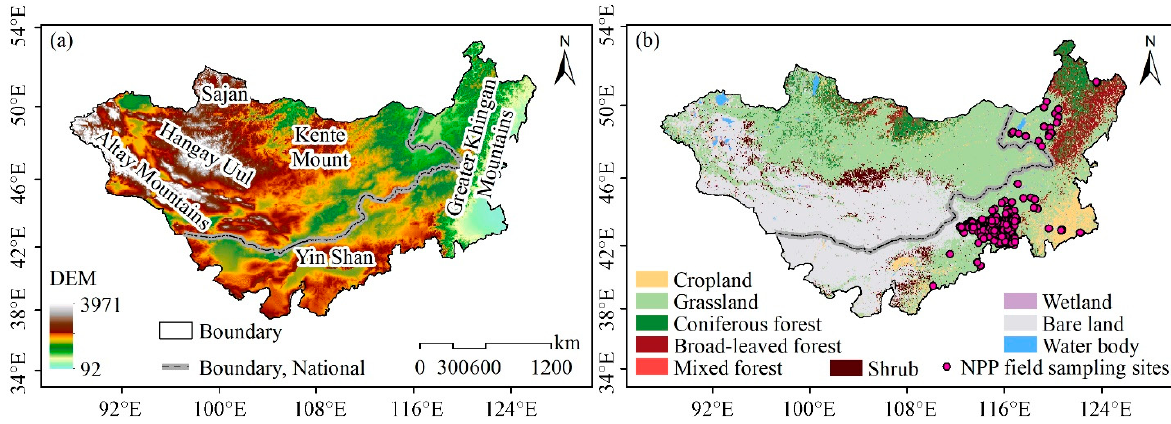
Figure 1. Topography ( a ) and land cover type ( b ) of the Mongolian Plateau.